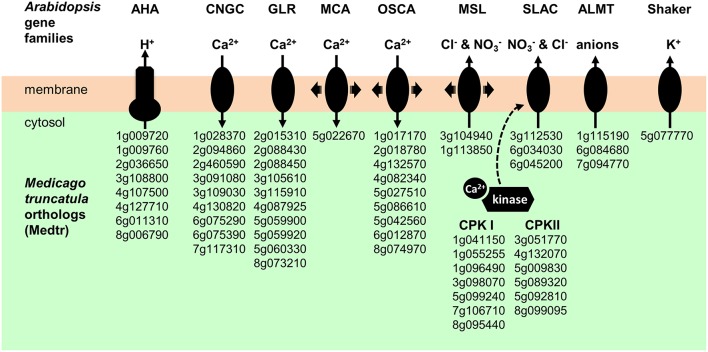
Plasma membrane transport systems and regulatory kinases likely to play a role in early electrical and calcium signals triggered by NF perception. AHA, Autoinhibited H+-ATPase. CNGC, Cyclic Nucleotide-Gated Channels. GLR, Glutamate Receptor-Like. MCA; Mid1-Complementing Activity. OSCA; Reduced hyperosmolarity-induced Ca2+ increase. MSL, Mechano-Sensitive MscS-Like channel. SLAC, Slow Anion Channel. ALMT, ALuminium-induced Malate Transporter. CPKI and CPKII, Calcium-dependant Protein Kinase I and II.